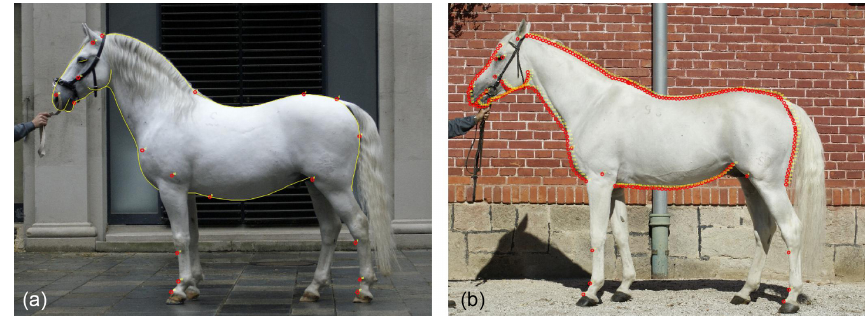
Figure 1. Shape model for phenotyping the horses. On the Lipizzan stallion (a) 31 single landmarks and eight outline curves (yellow line) are shown. The outline curves were transformed into single sliding semi-landmarks, which are illustrated on the Shagya Arabian stallion in panel (b) (illustrations and photos by Thomas Druml).